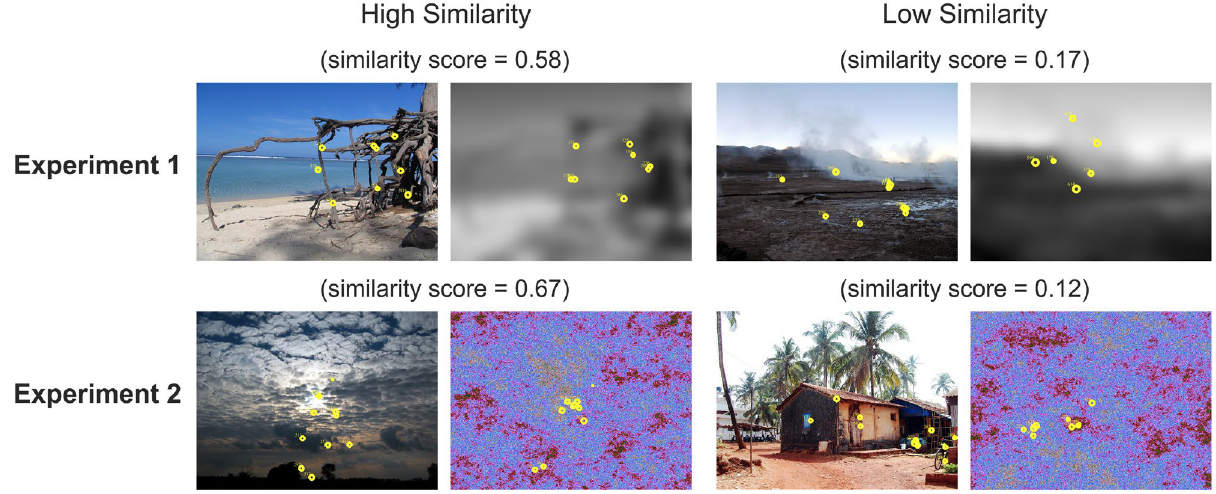
Figure 2. Examples of high and low similarity scores, for both Experiments 1 and 2. High similarity is visualized in the left column, while low similarity is visualized in the right column. Each yellow circle denotes a